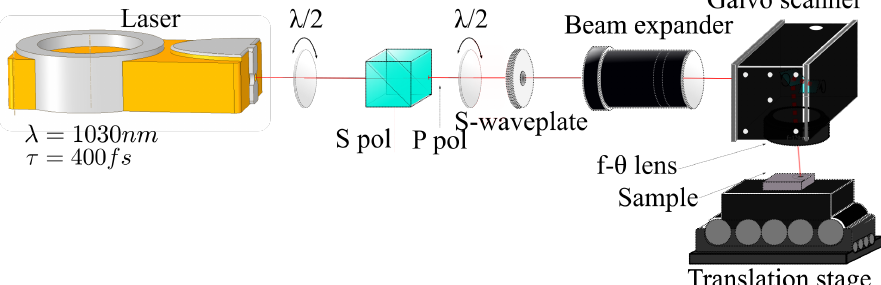
Figure 1. Schematic presentation of the laser inscription setup: s-wave-plate shifts linearly polarized into CV beam and then the scanner focuses the beam onto the